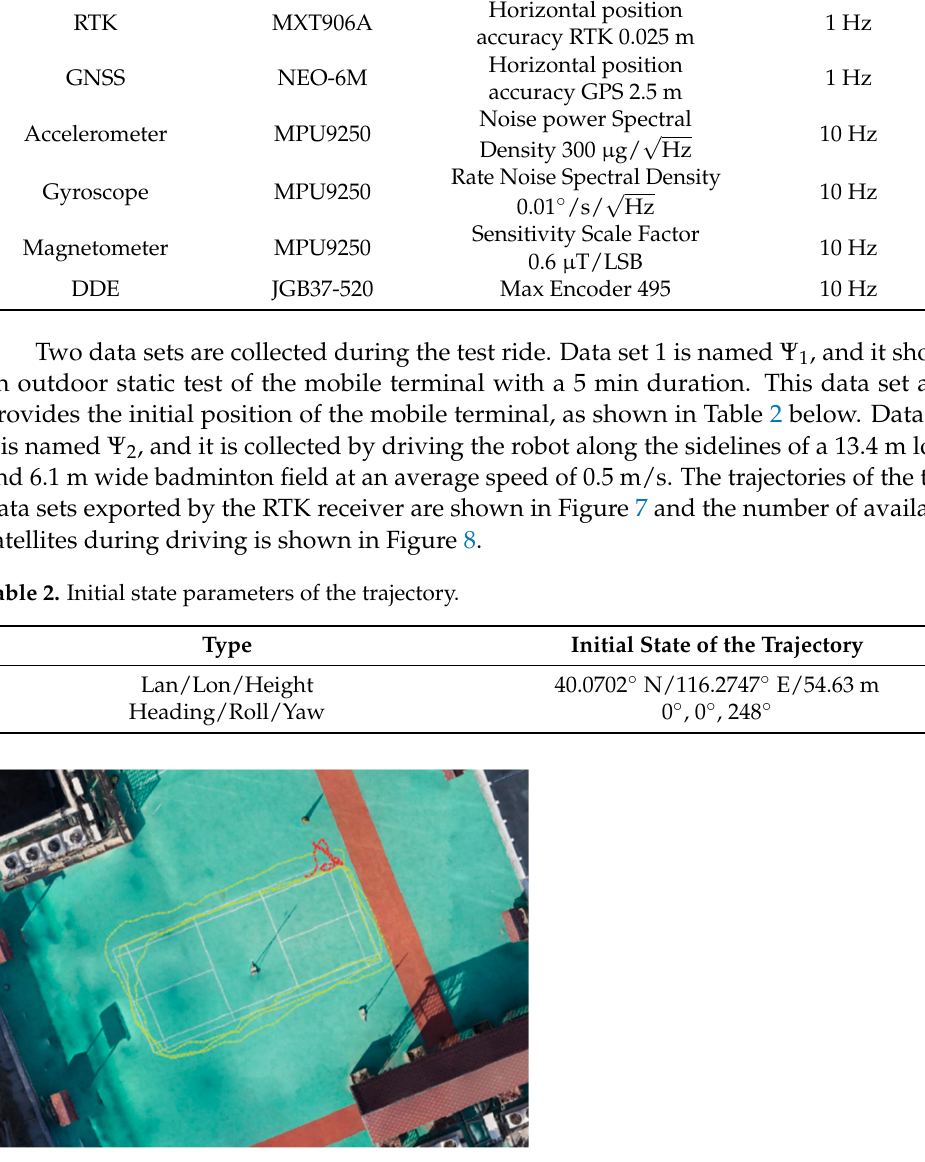
Table 1. List of sensor simulation parameters.